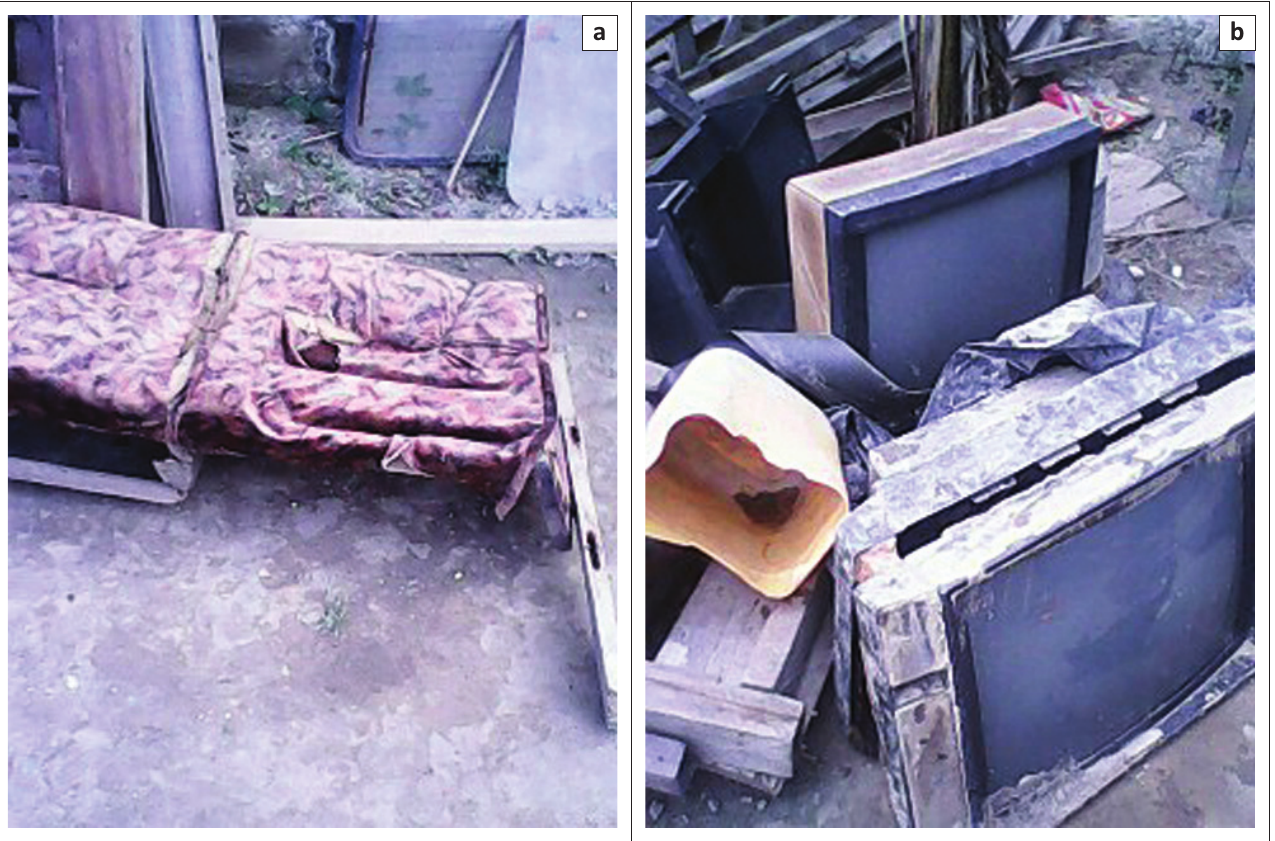
FIGURE 4: Some destroyed properties in a household at Eshiem. (a) Destroyed beds due to flooding and (b) destroyed television sets due to flooding.